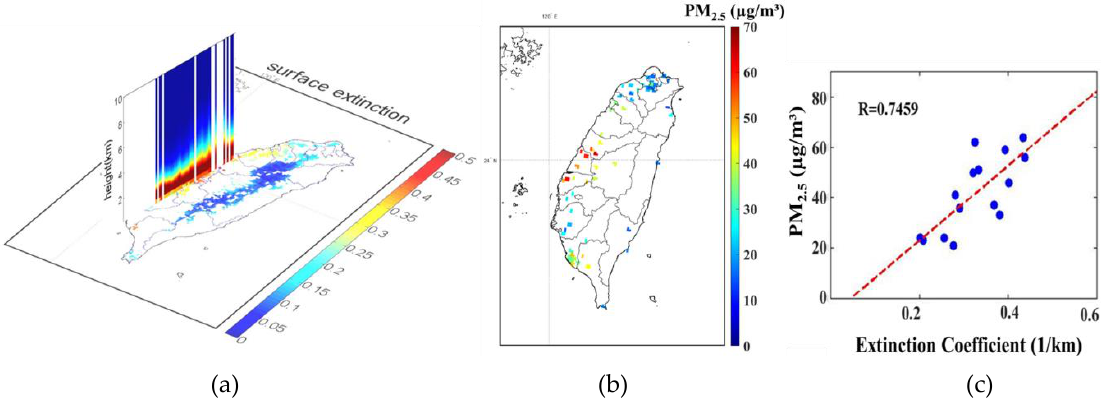
Figure 13. The results of the case study involving satellite observations at 11:00 LT on October 29, 2014. ( a ) The fitted 3D extinction coefficients over Taiwan; ( b ) the distribution of ground-based PM 2.5 ; and ( c ) scatter plots of extinction coefficients within surface layer from MODIS AOD with ground-based PM 2.5 . R is the correlation coefficient.